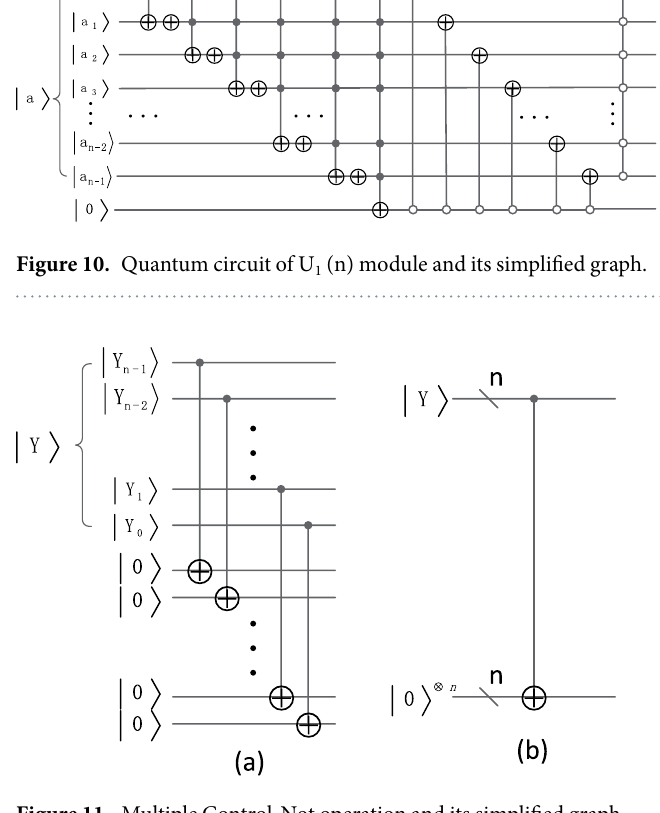
Figure 11. Multiple Control-Not operation and its simplified